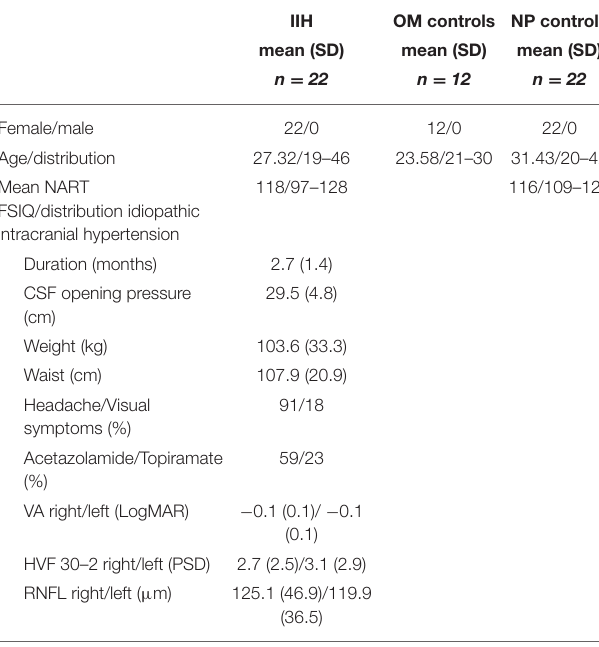
TABLE 1 | Demographic information for all